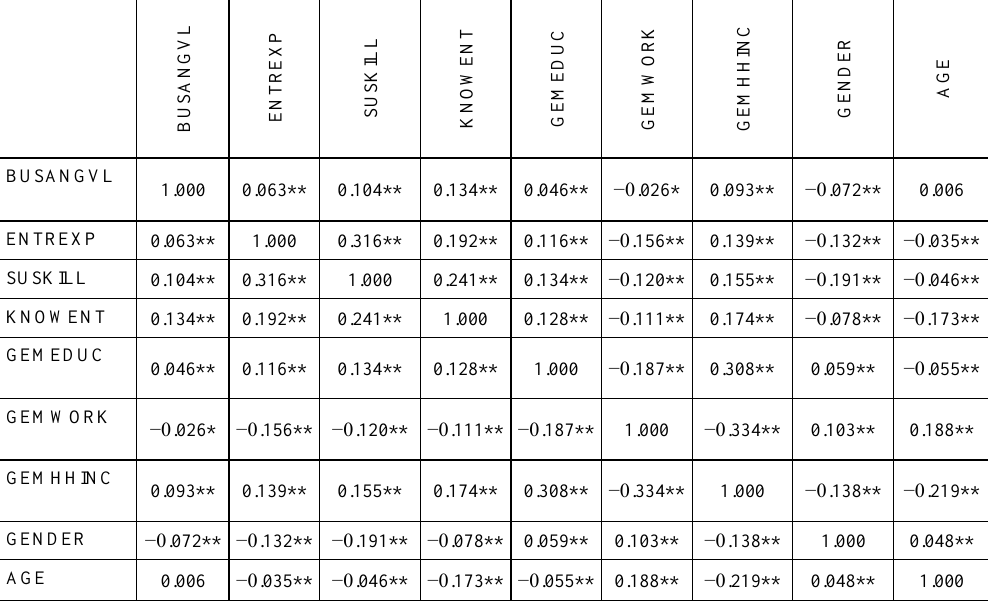
Table 2. The Spearman’s Rank Correlation of the Indicators Included in the Analysis of the Innovation-Driven Economies of Central